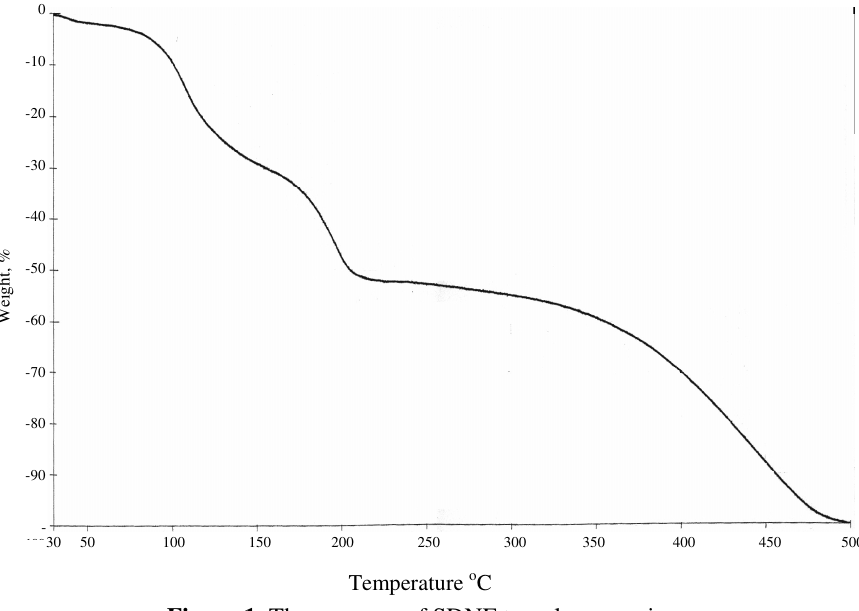
Figure 1. Thermogram of SDNF terpolymer resin.